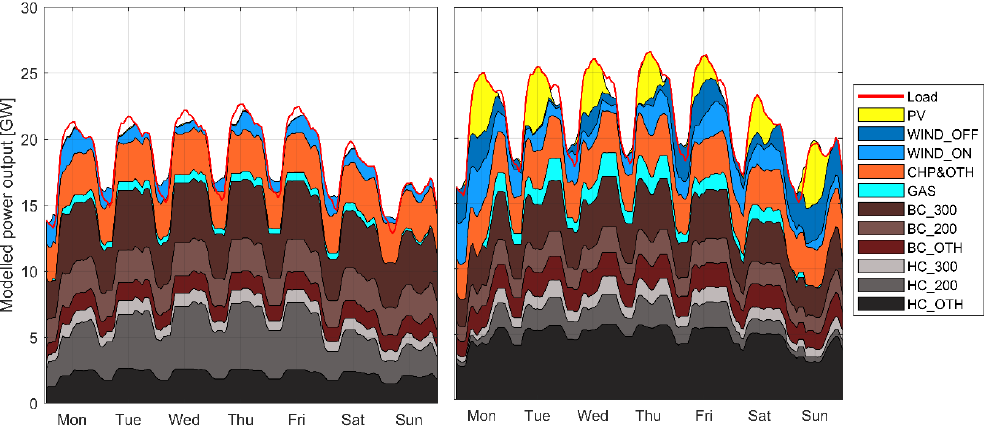
Figure 6. Electricity generation by sources in the first week of July in 2018 (left-hand side) and 2030 (right-hand side).